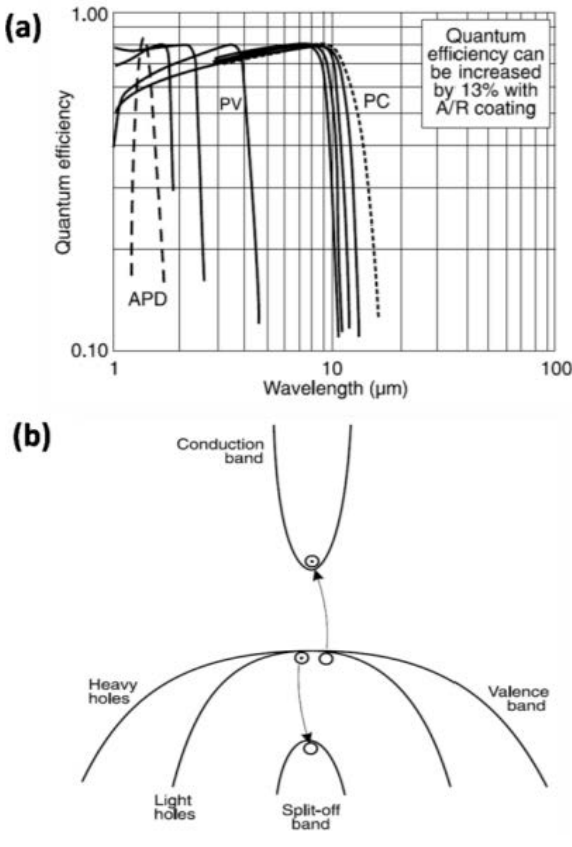
Figure 6: (a) Spectrum quantum eflciency for the HgCdTe PDs with- out antireflection coating. Short wavelengths type APDs are in de- velopment. Antireflection coating raised the quantum eflciency to > 90%. (b) Band structure for alloy composition at which the band gap is about 0.9 eV, corresponding to 1370 nm. At this composition, the split-off band is separated from the top of the conduction band by the same energy. This resonance condition allows very favorable multiplication of holes. Figures with reprint permission from: (a) & (b) Ref. [141] ©1999 Electrochemical